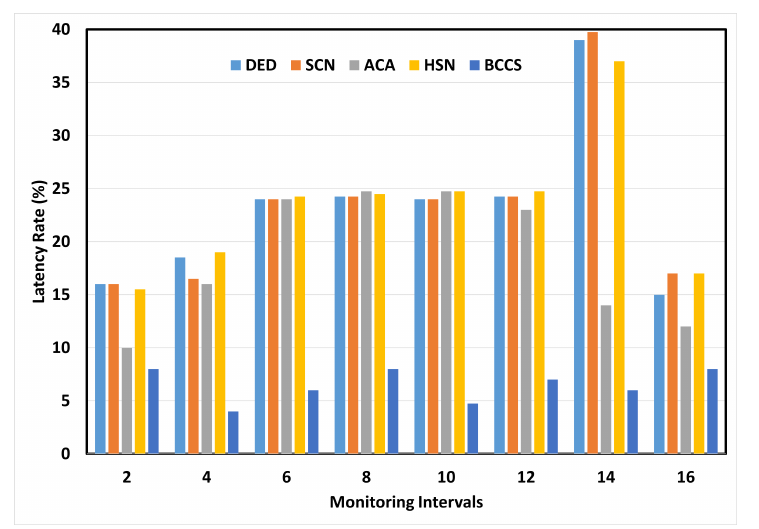
Figure 11. Latency rate (monitoring intervals). Table 2. Experimental results for monitoring